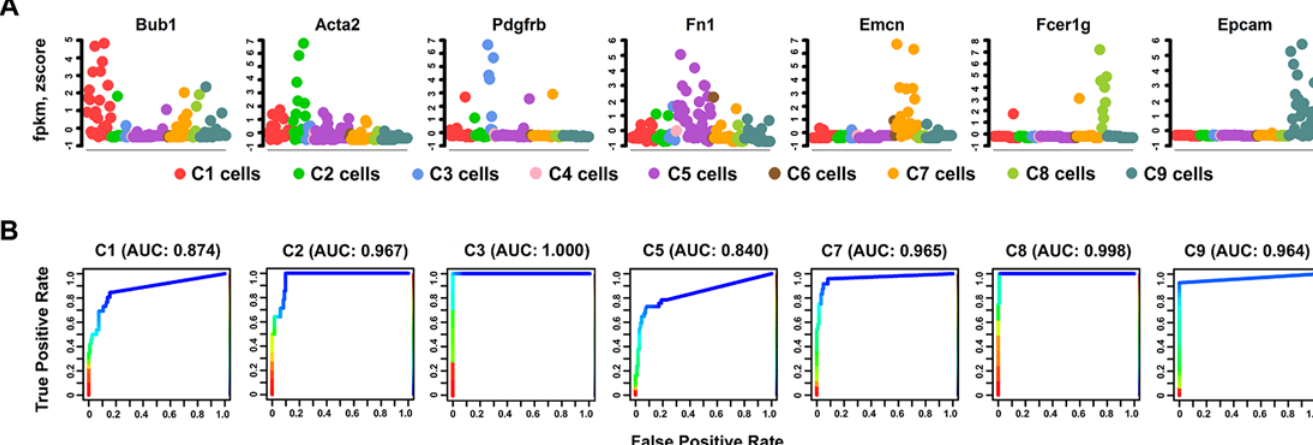
Fig 3. Validation of Cell Type Assignments using Known Biomarkers. (A) Expression patterns of representative known cell type markers were used to validate the correct assignment of major lung cell types at E16.5. Expression levels were normalized by per-sample z-score transformation. (B) ROC curves of the rank-aggregation-based validation showed a high consistency (AUC > 0.8) between the cell type assignments and the expression patterns of known cell type specific markers ( S2 Table ).